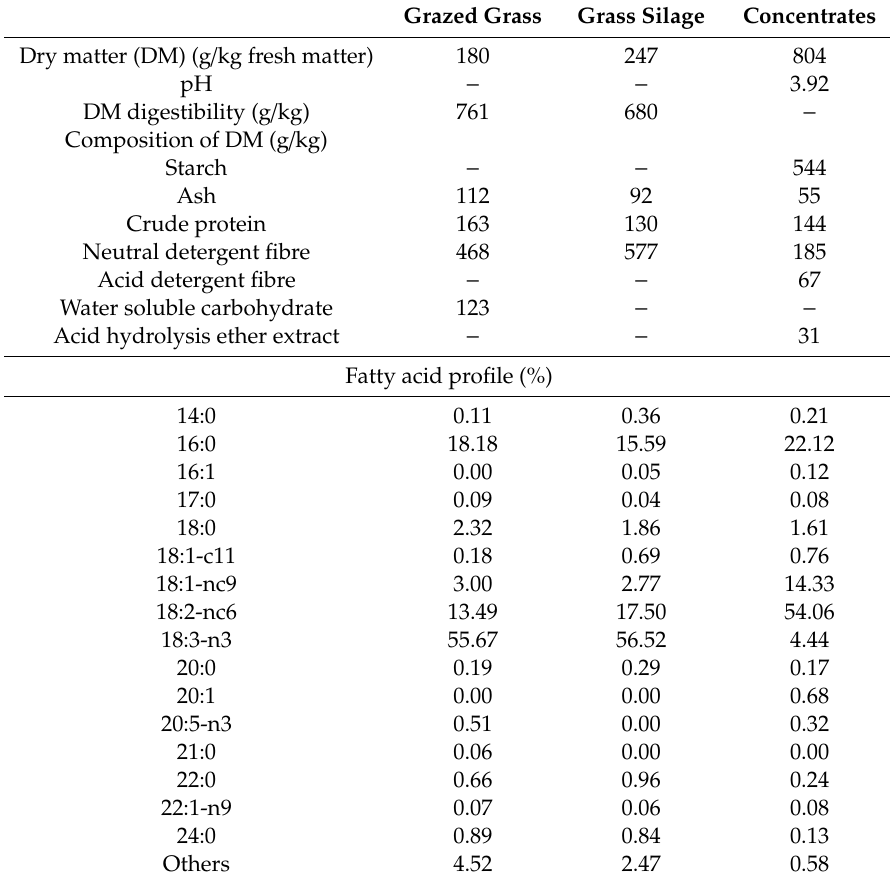
Table 1. Chemical composition of the dietary